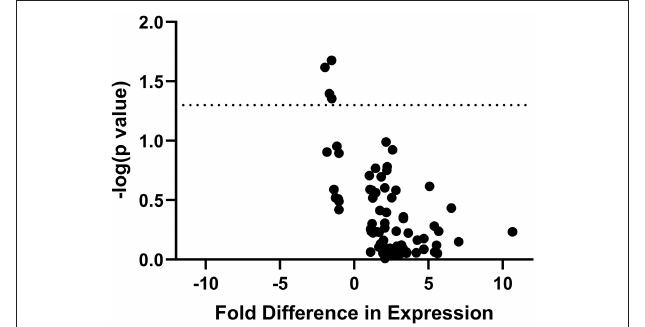
FIGURE 4 | “Volcano Plot” of statistical significance (-log[p value] of association with PBI score) against fold difference in expression for all IBS/FAP patients. The figure demonstrates the four of 84 genes ( GRIN1, MAPK3, P2X4, PTGES3 ) whose expression is significantly associated with pain burden in the patient population.